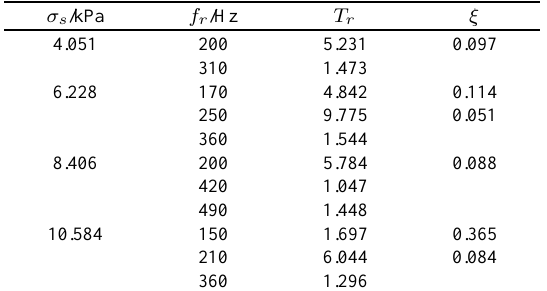
Table 5 Vibration transmissibility of honeycomb paperboard ( T = 50